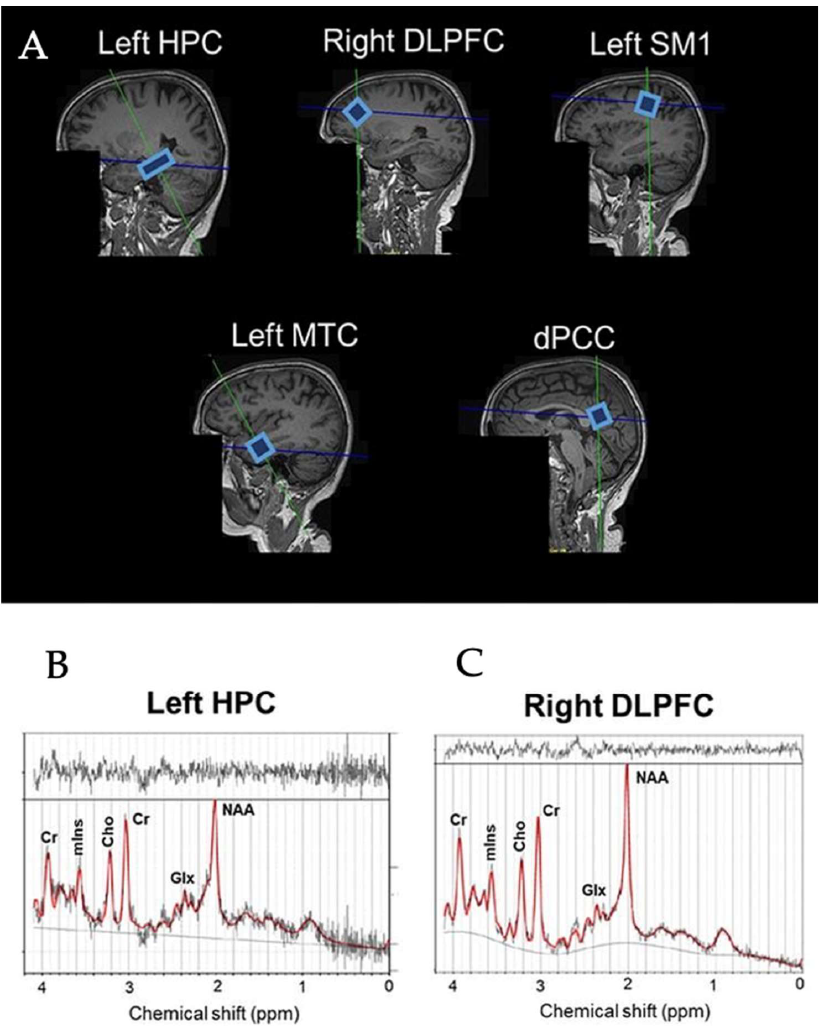
Figure 1. Example voxel positions placed on all ROIs in the brain ( A ) and spectra of left HPC ( B ) and right DLPFC ( C ) from a representative subjects. HPC = hippocampus, DLPFC = dorsolateral prefrontal cortex, SM1 = sensorimotor cortex, MTC = medial temporal cortex, dPCC = dorsal